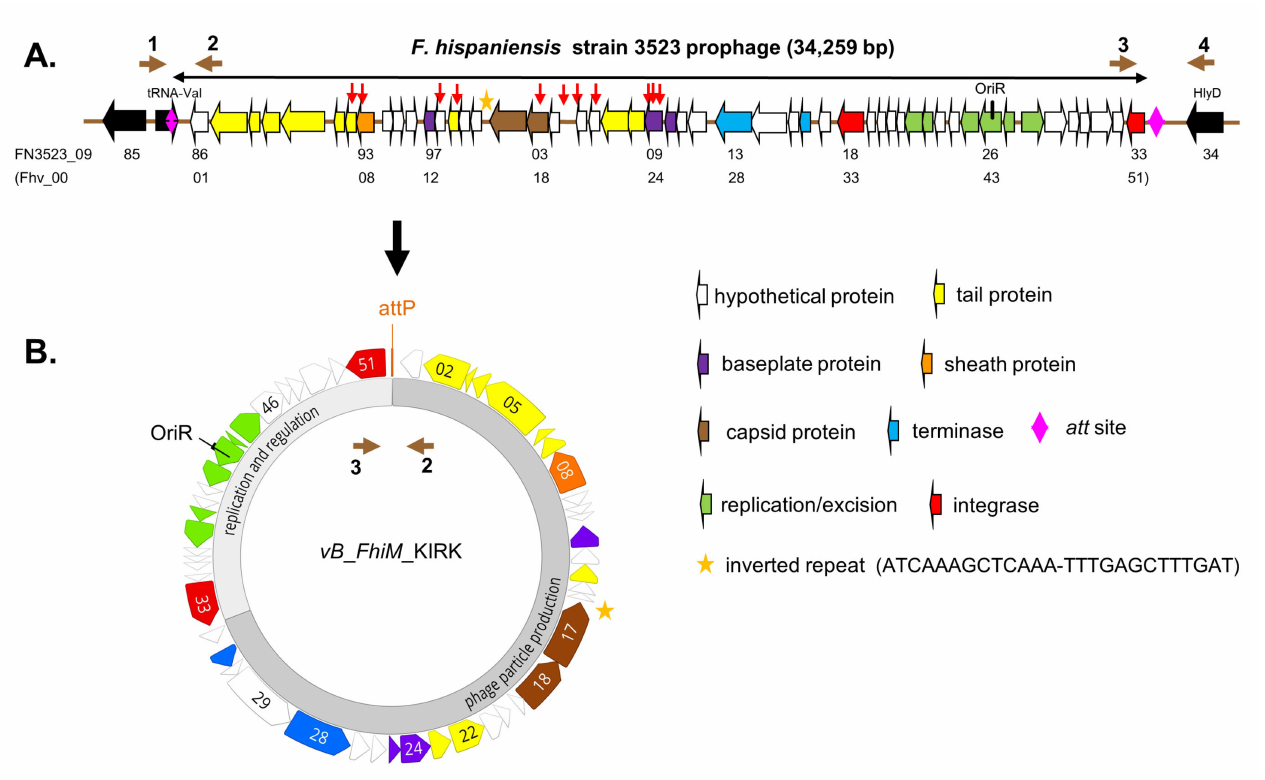
Figure 1. Organization of Francisella bacteriophage vB_ Fhi M_KIRK as prophage ( A ) or its episomal form ( B ) . ( A ) : The prophage is integrated within the tRNA-Val gene (pink arrow). The att sites ( attL and attR ) are indicated by a pink trapezium. The attR site corresponds to the 3 (cid:48) end of the tRNA-Val. Chromosomal genes are given in black and genes of the bacteriophage are given in different colours according to their respective putative function based on BLASTp analysis (see also Table 1). A putative origin of replication (OriR) is indicated. Gene numbers are indicated below the genes as published for Fhi 3523 (FN3523; CP002558) or as determined in this work for the bacteriophage KIRK (FhV_0001 to FhV_0051). Location of the spacer DNAs identified in the CRISPR-Cas systems of different Francisella strains are indicated above of the genes by red arrows (Schunder et al., 2013; modified). Primer used in this study are indicated as brown arrows (for details see text). ( B ) : Gene organization of the episomal form of bacteriophage KIRK are given in different colours (see ( A )) due to their putative function and are clustered in “replication and regulation” and “phage particle production”. The site-specific DNA region of KIRK ( attP ) responsible for the integration into the genome of host cells ( attB , not shown) is indicated. Prophages (integrated bacterial virus genomes) are commonly found in many bacterial genomes, encoding viruses/phages that can infect bacteria (bacteriophages).